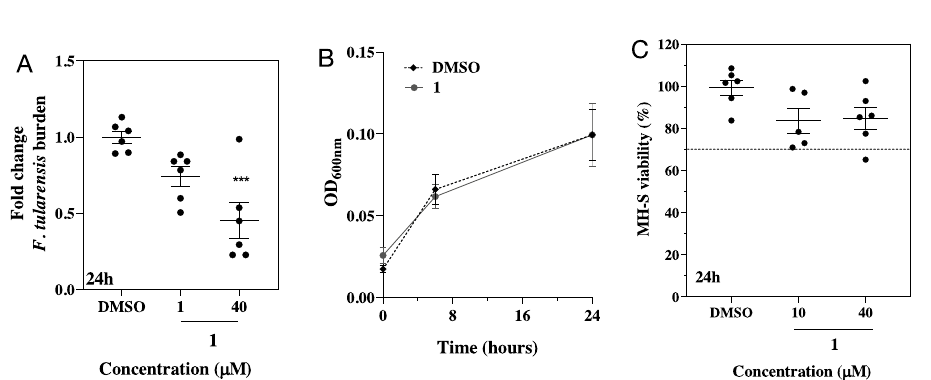
Figure 4. Effect of compound 1 on F. tularensis growth and intracellular burden. ( A ) Dose dependent efficacy of compound 1 on F. tularensis intracellular burden in MH-S macrophages at 24 h post infection. Bacterial burden was calculated from the average CFU/ml relative to DMSO control. Statistical significance was evaluated by one-way ANOVA (Dunnett’s test) compared to DMSO control (*** p < 0.001). Error bars indicate ± SD of two independent experiments. ( B ) MH-S cells viability in percentage at 24 h post treatment with compound 1 . Percentage of viability was calculated relative to the control (RPMI media only). Dashed black line indicates 70% viability. Error bars indicate ± SD of three independent experiments. ( C ) Effect of compound 1 on the acellular growth of F. tularensis monitored over 24 h using optical density (OD 600 ). Cultures were treated with 40 µM of the inhibitor. Negative control is DMSO. Error bars indicate ± SD of